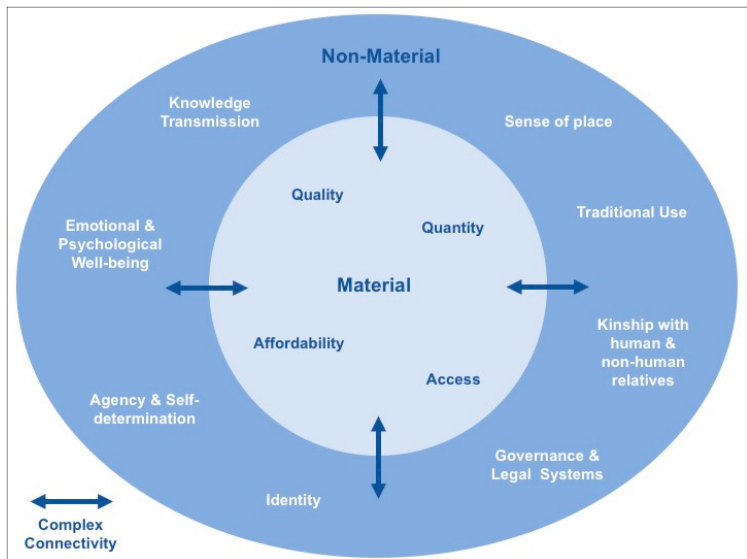
Figure 1. This diagram rearticulates water security according to Indigenous water relations based on holistic understandings of the complex connections between material and non-material dimensions of water. While we separate the material from non-material dimensions of water security we do so for conceptual ease and do not intend to reinforce a false dichotomy between nature and culture and the tangible and intangible dimensions of water.